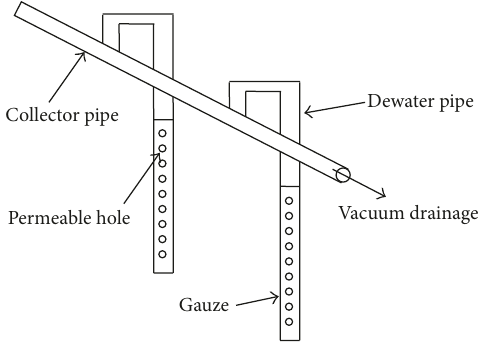
Figure 1: Diagram on light well point method.